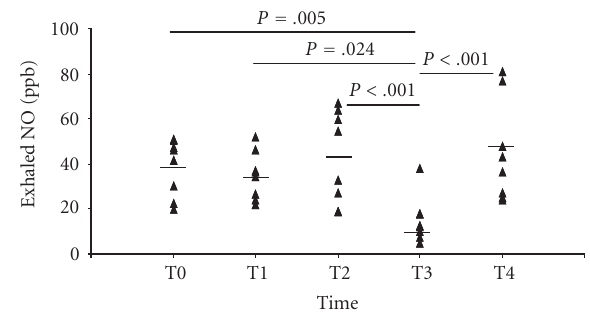
Figure 1: Individual data points of FeNO levels at the times of the study (T0, T1, T2, T3, and T4). Marked short lines represent mean